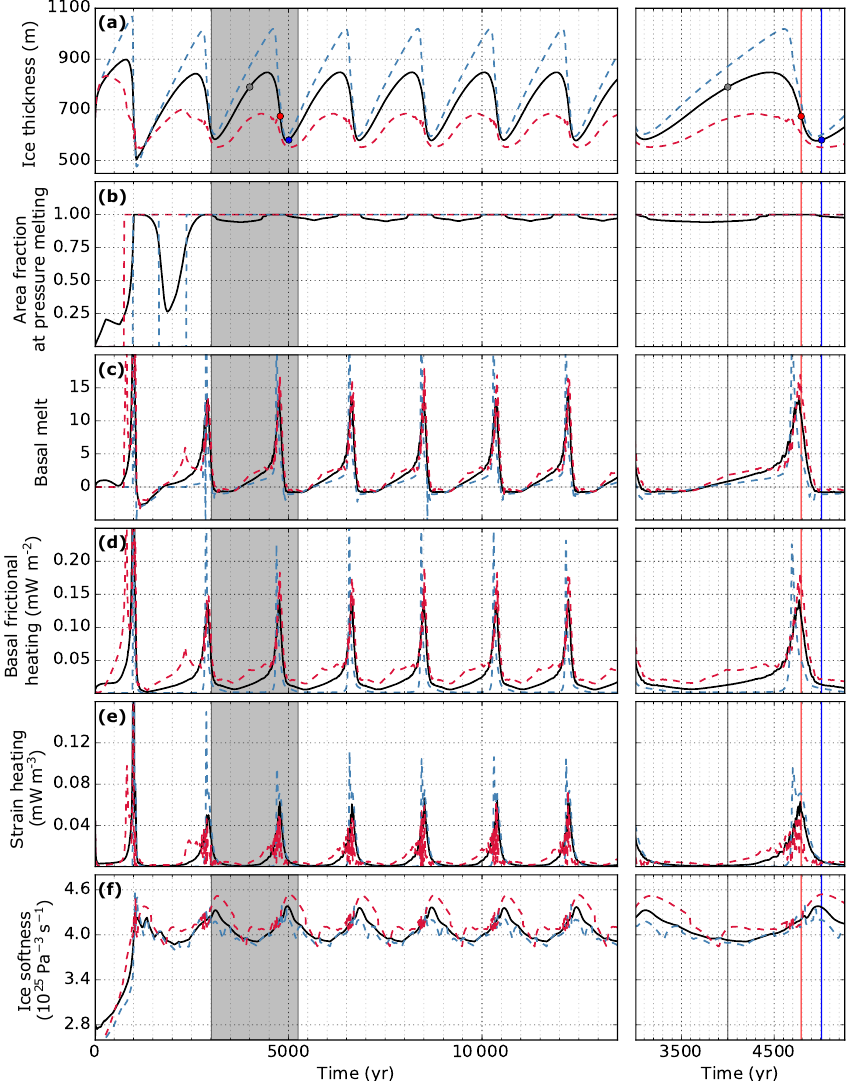
Figure A3. Time series complementing Fig. A2, showing centerline-averaged values (black curve) and two point measurements on the centerline (dashed blue and red curves; locations highlighted by squares in Fig. 1a) instead of grounded-area averaged